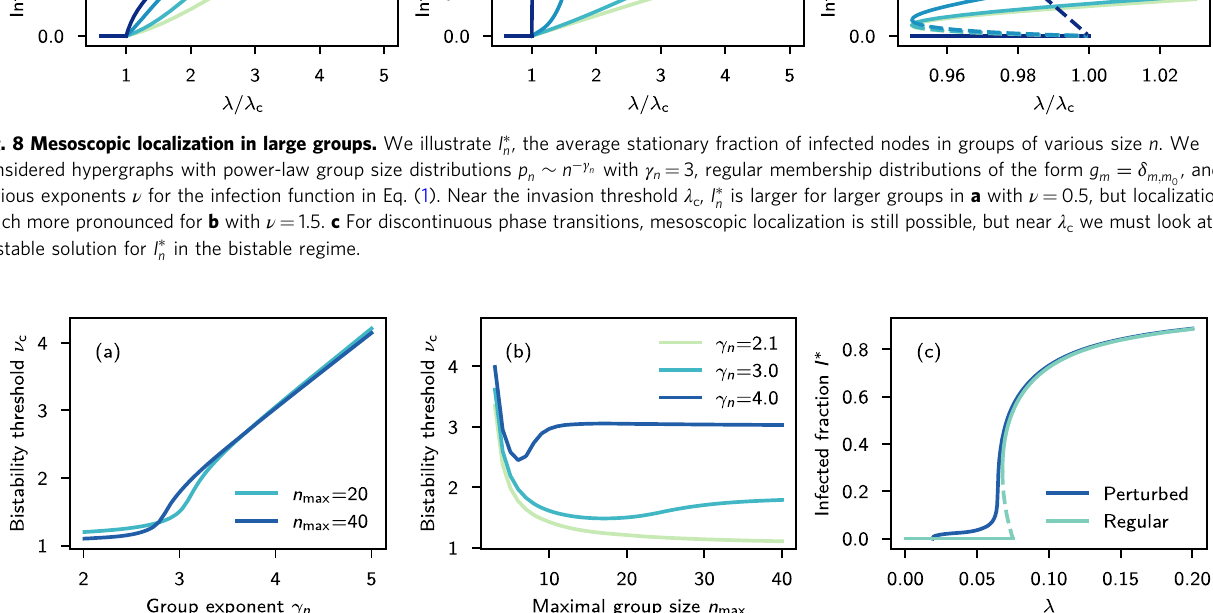
Fig. 9 Impact of heterogeneous group sizes on the bistability threshold. We considered hypergraphs with power-law group size distributions p n (cid:5) n (cid:2) γ n with various exponents γ n and a regular membership distribution g m = δ m ,4 . We solve the bistability threshold using Eq. (21). Lower values of γ n imply a more heterogeneous group size distribution. a For a fi xed n max , the bistability threshold increases with larger γ n . b For a fi xed γ n , the bistability threshold has a nonmonotonic relationship with n max . c Phase transition using g m = δ m ,4 and ν = 2.3. We use p n = δ n ,4 for the regular case, and p n = (1 − ϵ ) δ n ,4 + ϵδ n ,15 with ϵ = 10 − 3 for the perturbed case. Mesoscopic localization 49, 50 inhibits bistability in the perturbed case.